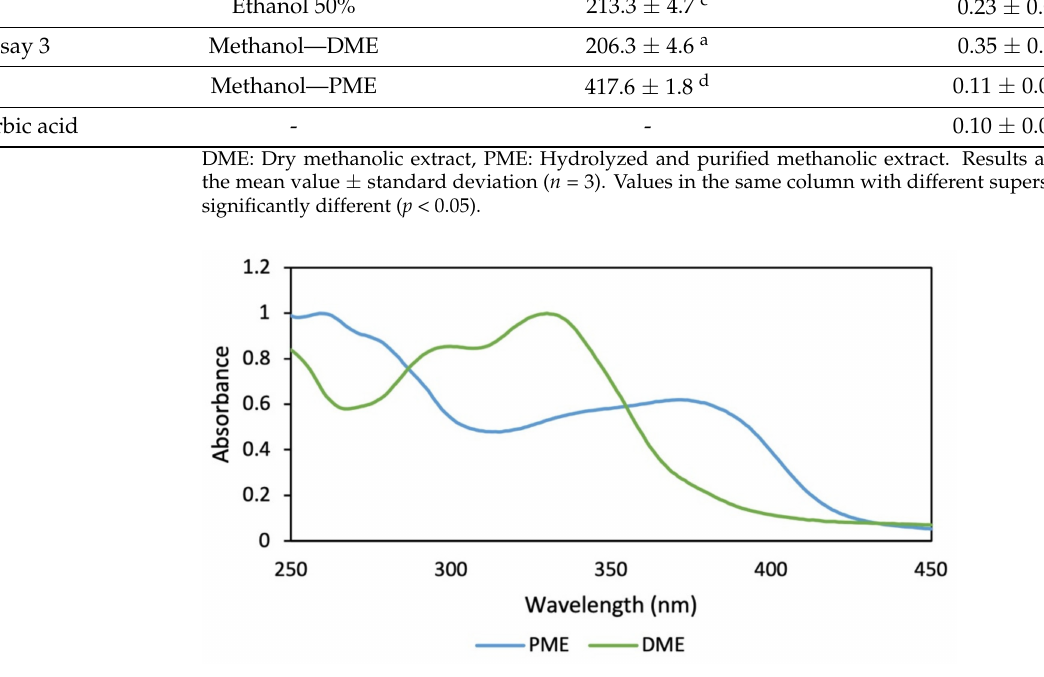
Figure 6. Absorption spectra of dry methanolic extract (DME) and hydrolyzed and purified methano- lic extract (PME) of B. antioquensis